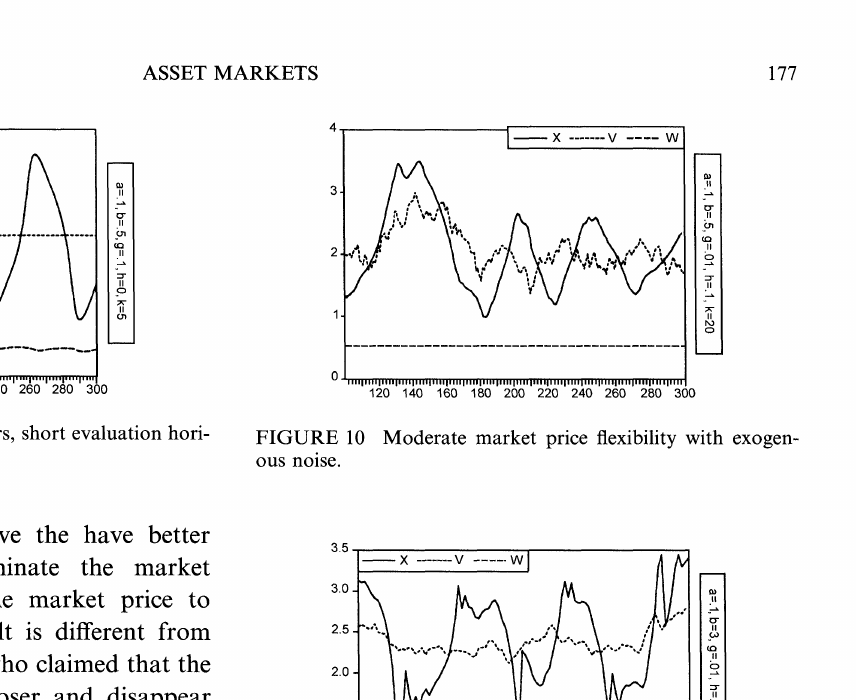
FIGURE 8 F-traders versus N-traders, short evaluation hori- zon.